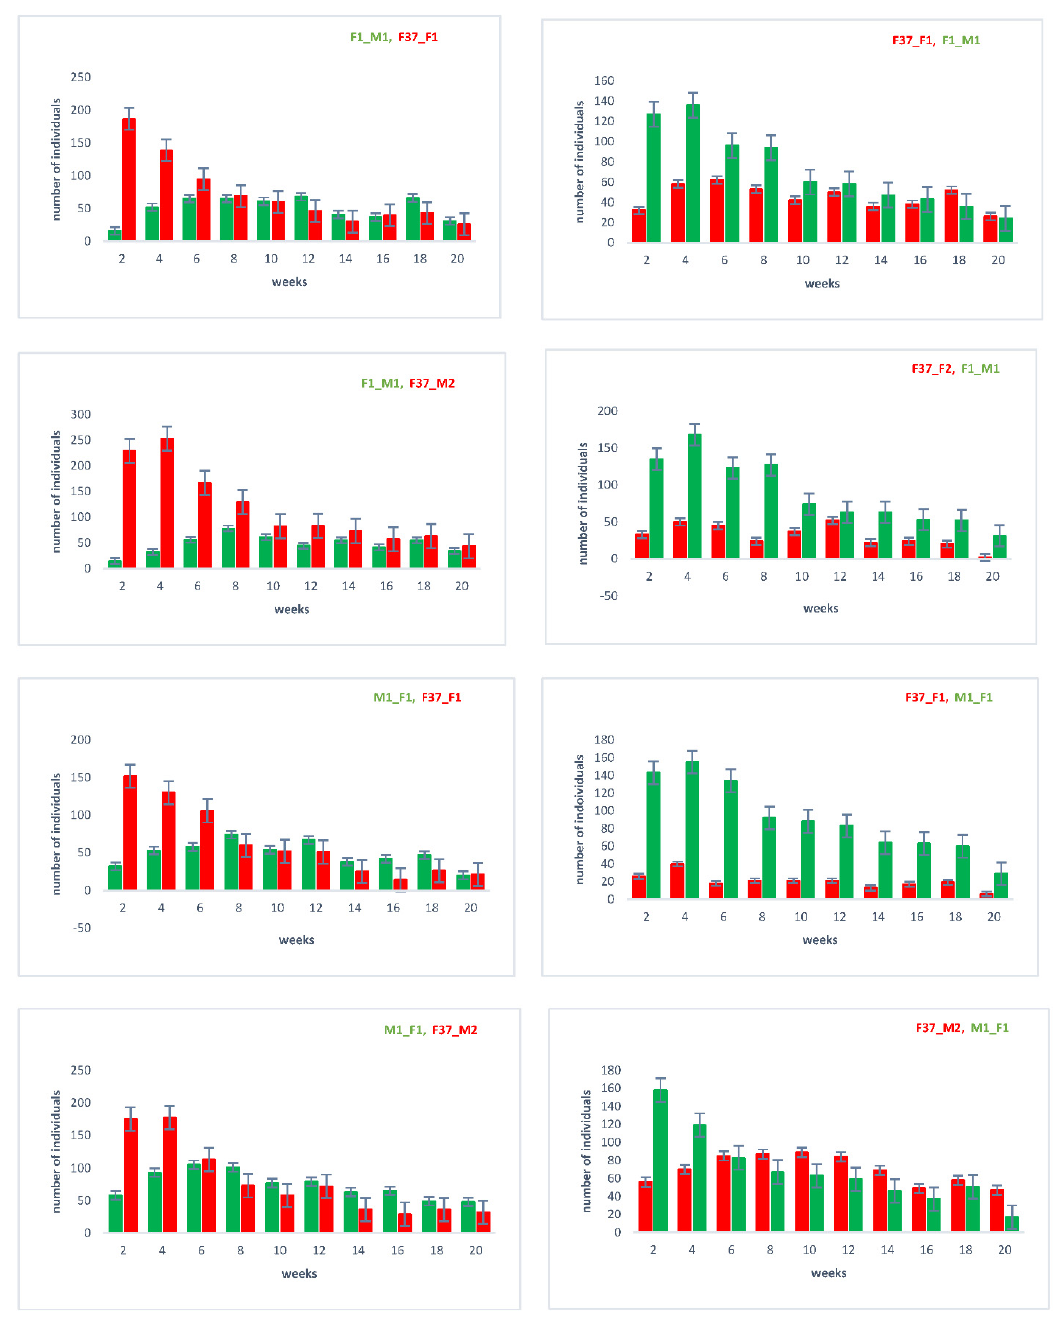
Figure 4. Sperm utilization and competition of sequentially twice-mated females. Mating events were performed as indicated in Supplementary Figure S1, with the order of the respective lines indicated above on each chart. In the progeny, the number of individuals showing the respective eye marker (EGFP or DsRed; see Figure 1) was counted, which indirectly indicates the used sperm.